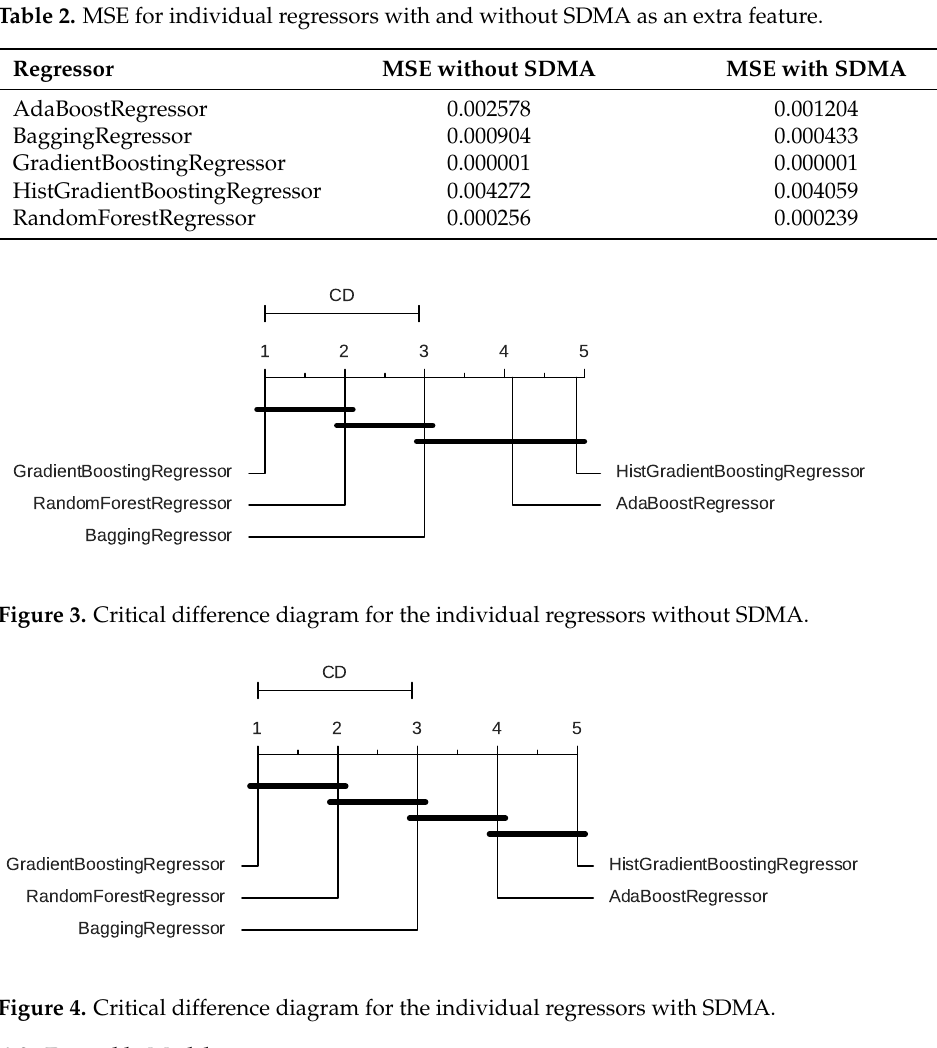
Figure 4. Critical difference diagram for the individual regressors with